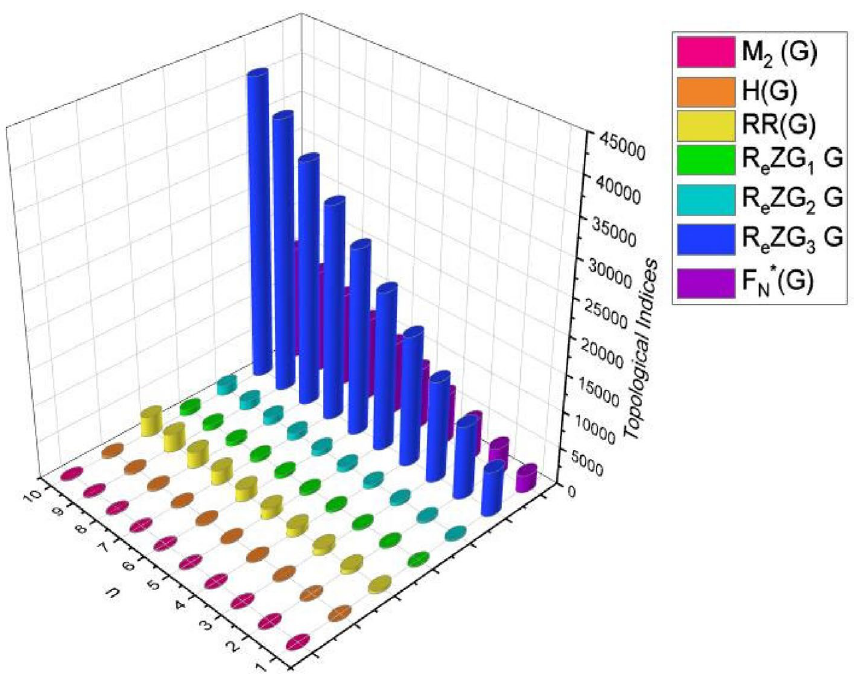
Figure 18. Comparison of topological indices for various values of n in ZNSL